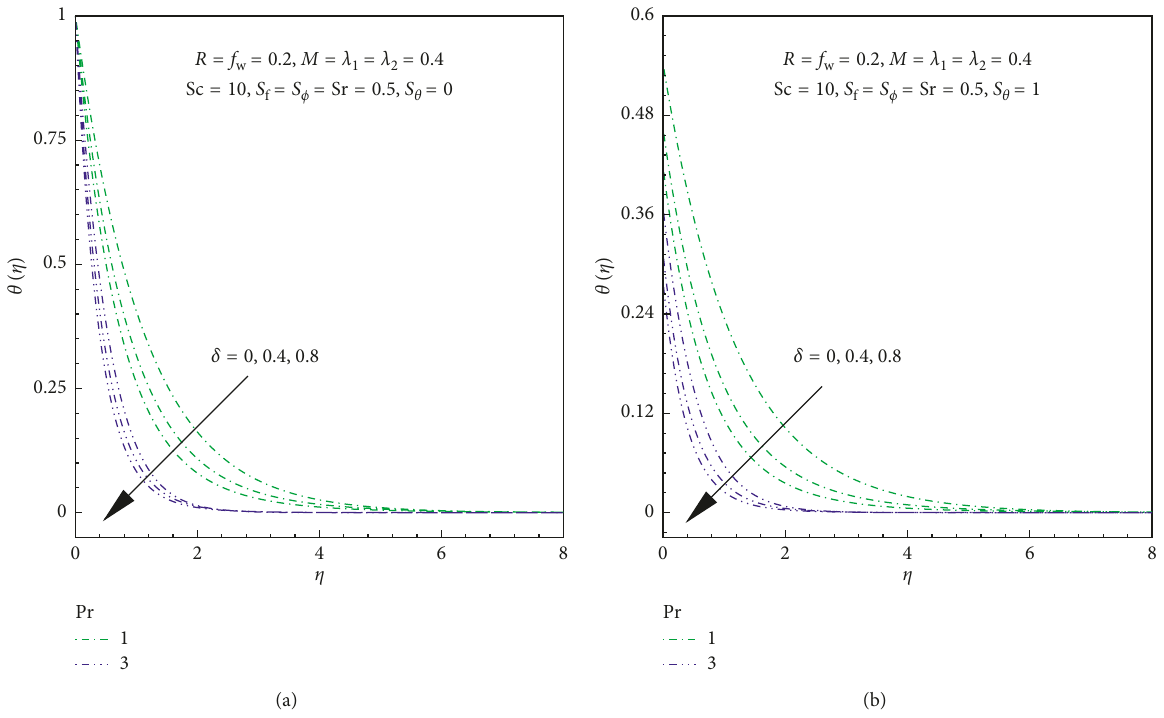
Figure 8: Effects of δ and Pr on dimensionless temperature. (a) No thermal slip. (b) With thermal slip.